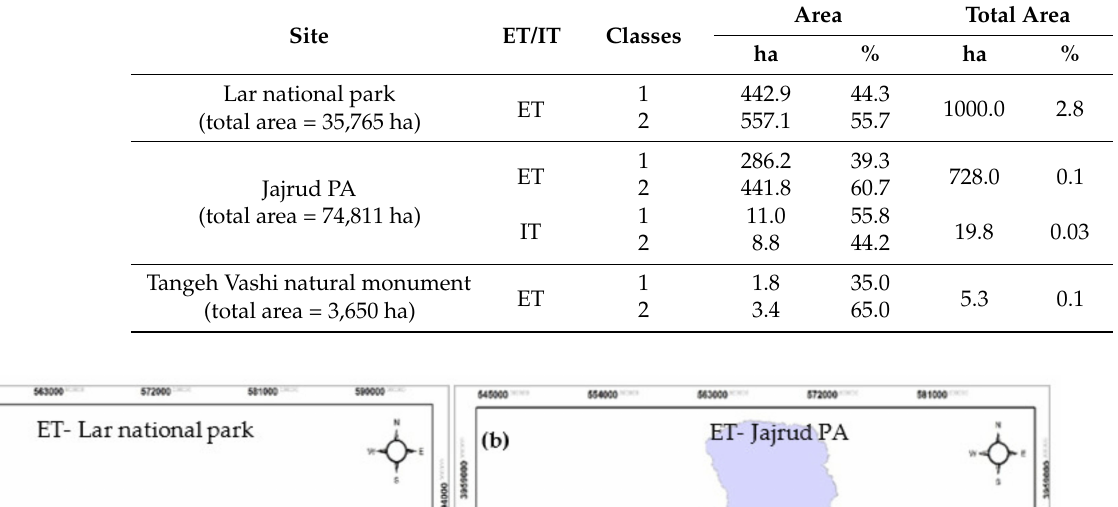
Table 4. Extensive ecotourism (ET) and intensive ecotourism (IT) recreation classes for the studied areas.